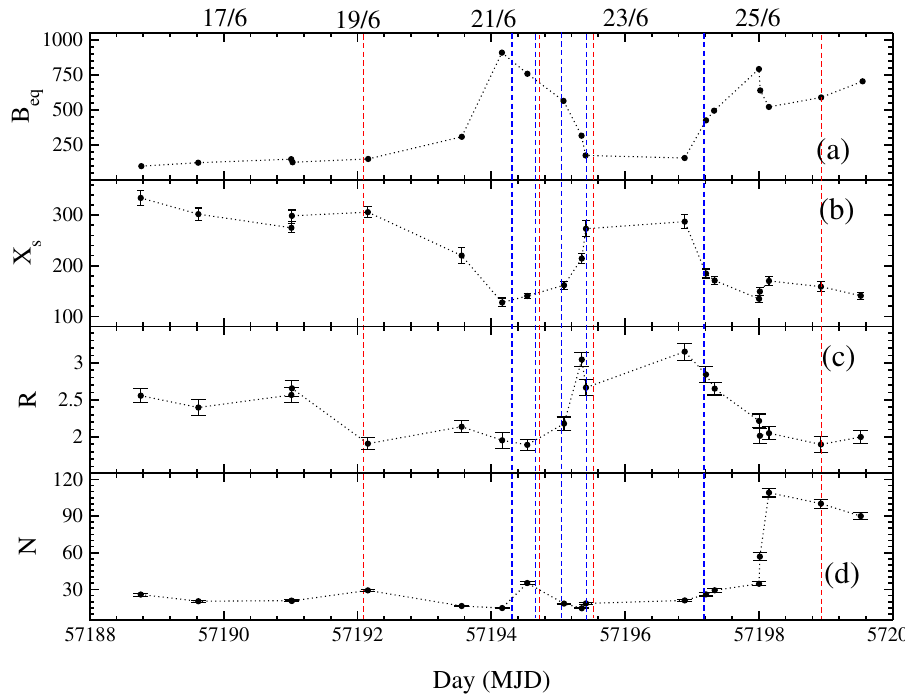
Figure 7. The variation ( a ) equipartition magnetic field ( B eq ) in Gauss , ( b ) shock location ( X s ) in r s , ( c ) shock compression ratio ( R ) and ( d ) normalization ( N ) are shown with day (MJD).